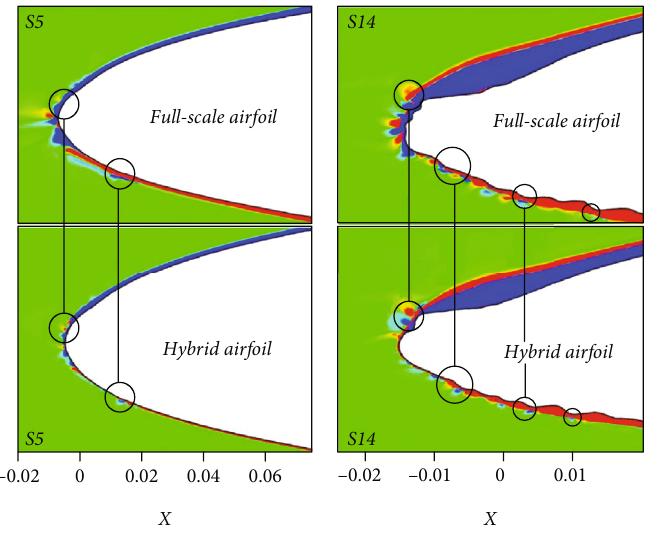
Figure 16: Variation of airfoil